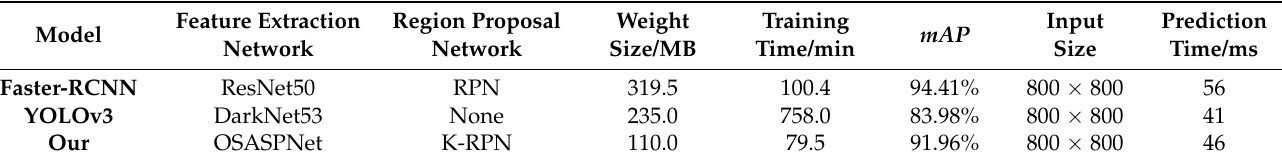
Table 5. Comparison of test performance between different